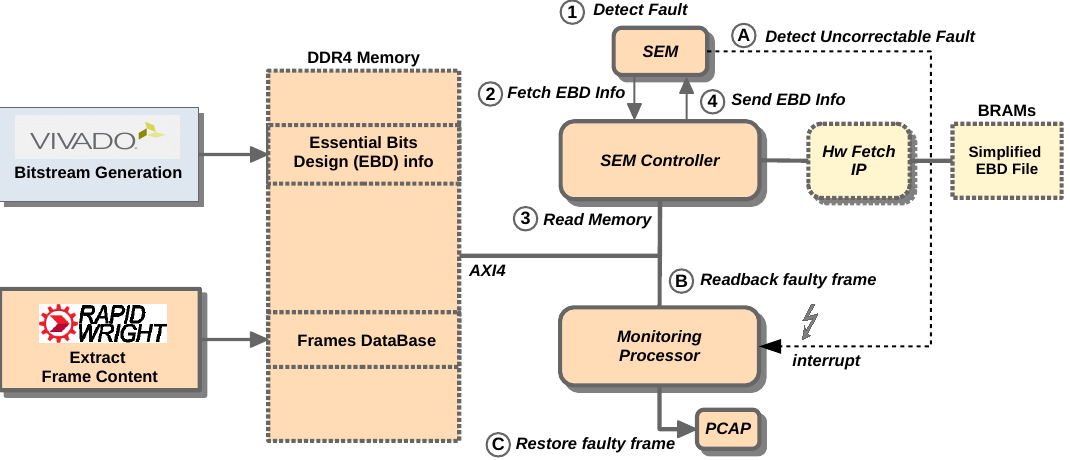
Figure 4. Custom Mitigation